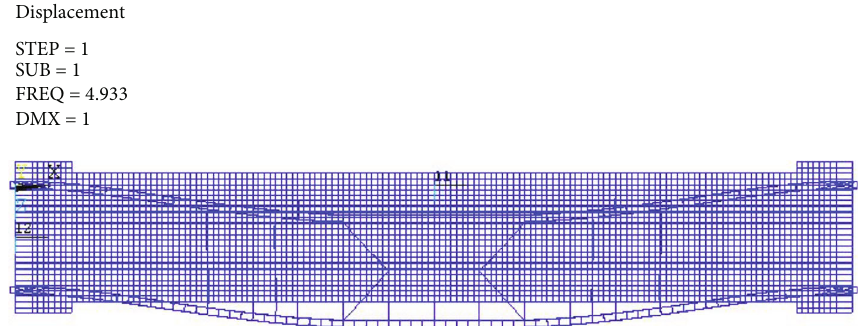
Figure 16: The fi rst order buckling mode of arch bridge under case 1.